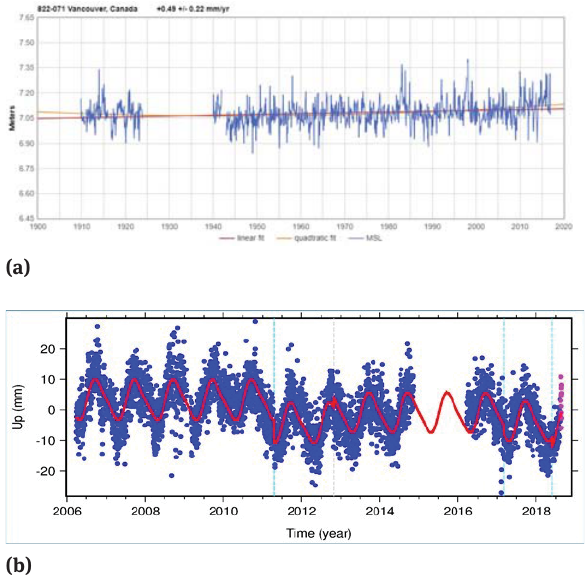
Figure 9: (a) MSL data for Vancouver, Canada. Image reproduced modified after [4]. (b) GNSS time series for P440. Image reproduced modified after NGL.